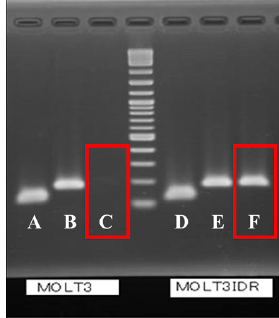
Figure 1. Identification of wild-type and mutant GALNT2 in MOLT-3 and MOLT-3/IDR cells via real-